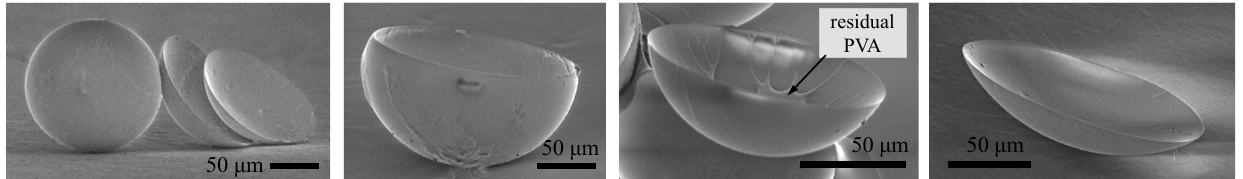
Figure 7. Images of deformed capsules: ( a ) By pressure change; ( b ) by external force; ( c ) by too high electric power.